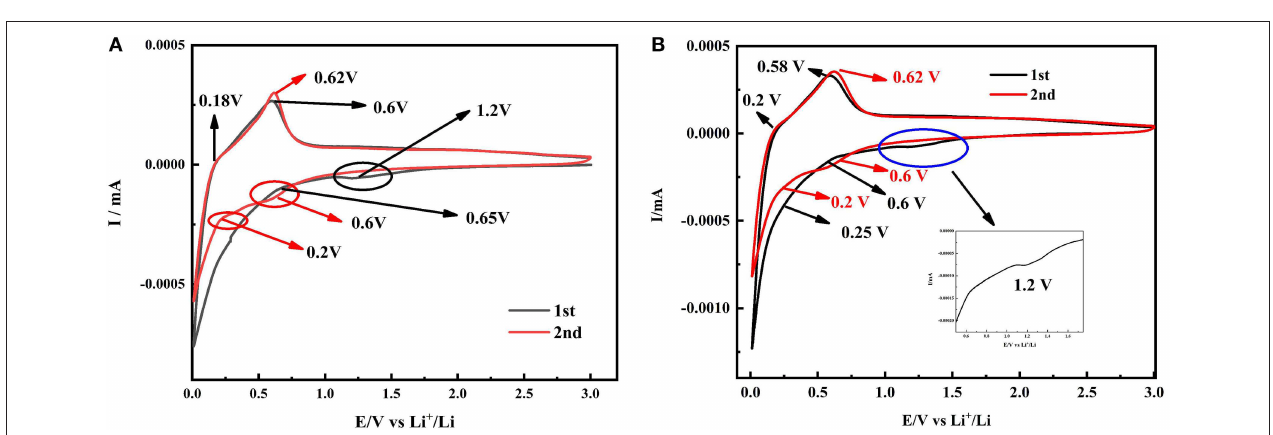
FIGURE 7 | CV curves of SiO x -G/PAA-PANi (A) and SiO x -G/PAA-PANi/graphene (B) electrodes at the scanning rate of 0.1mV s − 1 .